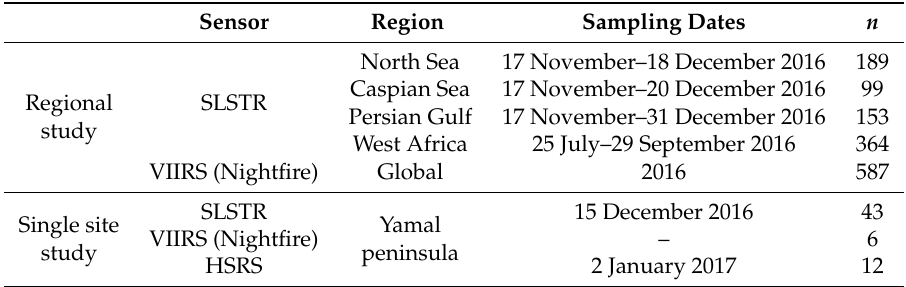
Table 2. Data used in this study. The number of VIIRS products was derived from the VIIRS Nightfire dataset from NOAA, corresponding to the products which exhibited detections co-located in space and